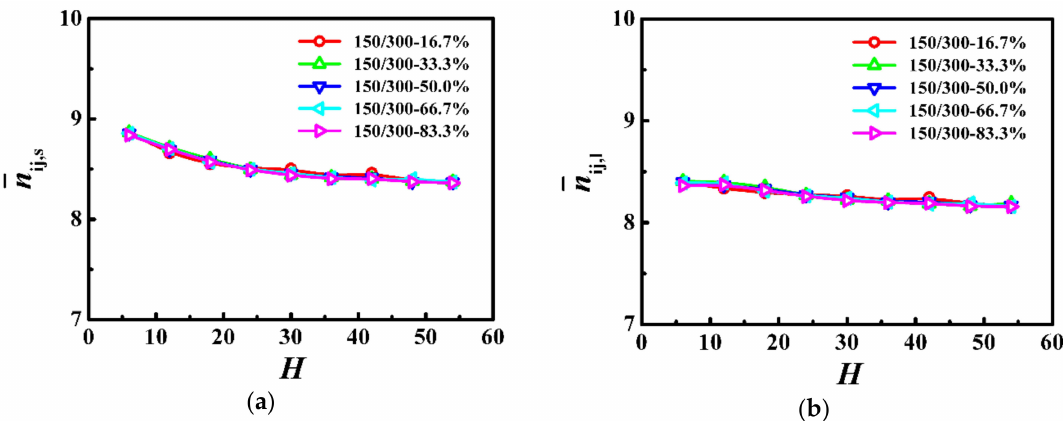
Figure 5. Average number of near-neighboring particles per monomer for ( a ) shorter ( n ij , s ) and ( b ) longer ( n ij , l ) chains as a function of the film thickness (H) in the model system of N s = 150 and N l =